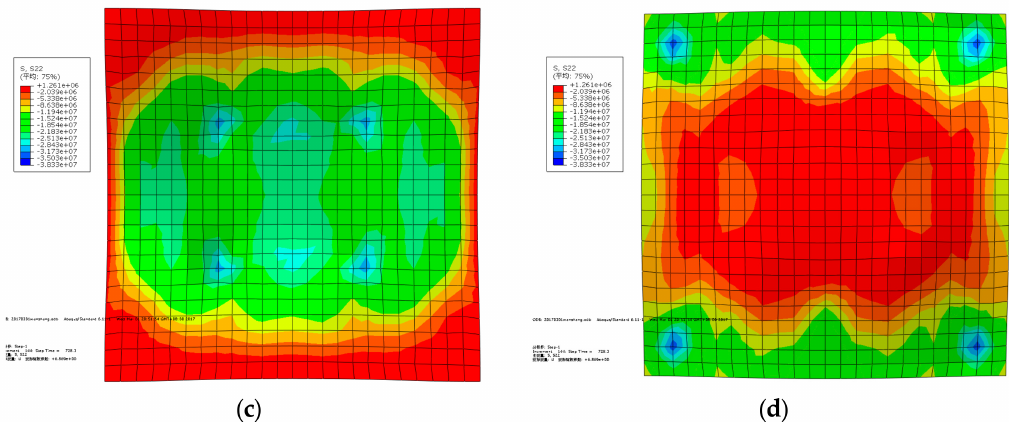
Figure 22. Mises stress contour figures of concrete and steel skeleton (ultimate). ( a ) Mises stress in the concrete compression zone; ( b ) Mises stress of the reinforcement skeleton; ( c ) S22 stress in the concrete compression zone; ( d ) S22 stress in the concrete tension zone.